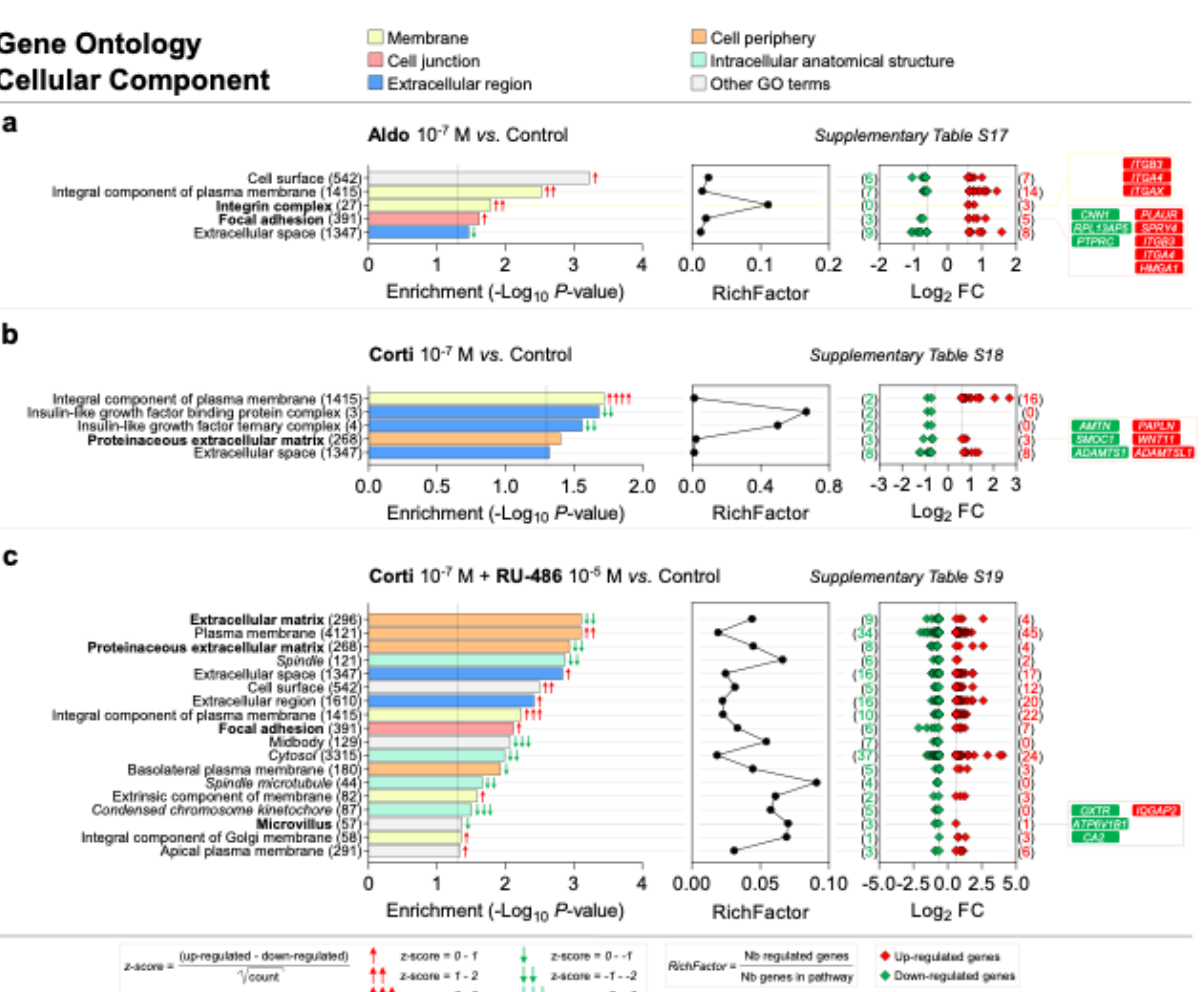
Scheme 3. Membrane, cell junction, extracellular region, cell periphery and intracellular anatomical structure are the most represented cellular component GO categories enriched in corticosteroid-treated iRPE cells. ( a )–( c ) Specific corticosteroid- regulated enriched cellular component gene ontology (GO) terms as predicted by bioinformatic enrichment analysis with their respective RichFactor value and the number of differentially expressed genes (DEGs) involved in the component, in iRPE cells treated for 24 h with aldosterone (aldo) 10 − 7 M ( a ), cortisol (corti) 10 − 7 M ( b ) or cortisol 10 − 7 M + RU-486 10 − 5 M ( c ) and compared to untreated cells. Cellular component GO terms are considered enriched if p value is < 0.05 and the number of regulated genes in the pathways is ≥ 2. p -values and fold-change (FC) values are represented in a -Log 10 and a Log 2 scale, respectively. Most represented enriched cellular component GO terms are regrouped into five categories: membrane , cell junction , extracellular region , cell periphery and intracellular anatomical structure ; GO terms of interest are highlighted in bold. Based on z-score values, green and red arrows in the left panel indicate down- and up-regulated GO terms, respectively. Numbers between parentheses placed after enriched cellular component GO term names in the left panels represent the total number of genes implicated in the respective GO term. Numbers between parentheses in the right panels indicate the number of down- (in green) and up-regulated (in red) genes in their corresponding GO term. Corticosteroid-regulated genes in cellular component GO terms of interest are listed in the right panel.